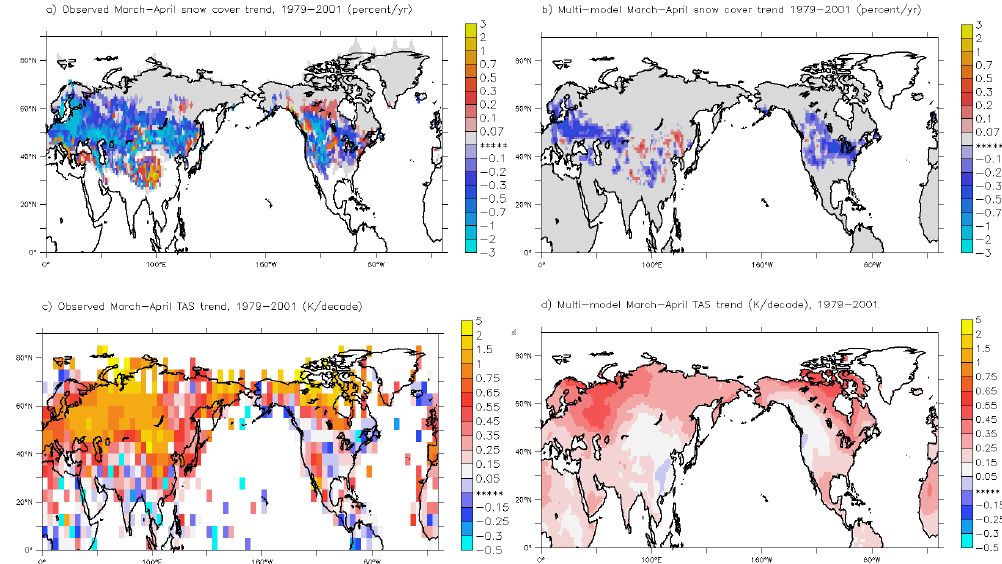
Fig. 5. Observed (left) and simulated (right, multi-model mean) trends of near-surface snow-related variables, for the 1979–2001 period.